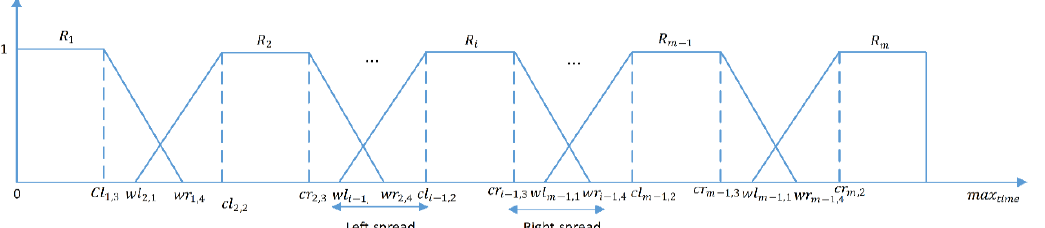
Figure 5. Time duration of each web page as the trapezoidal membership functions.